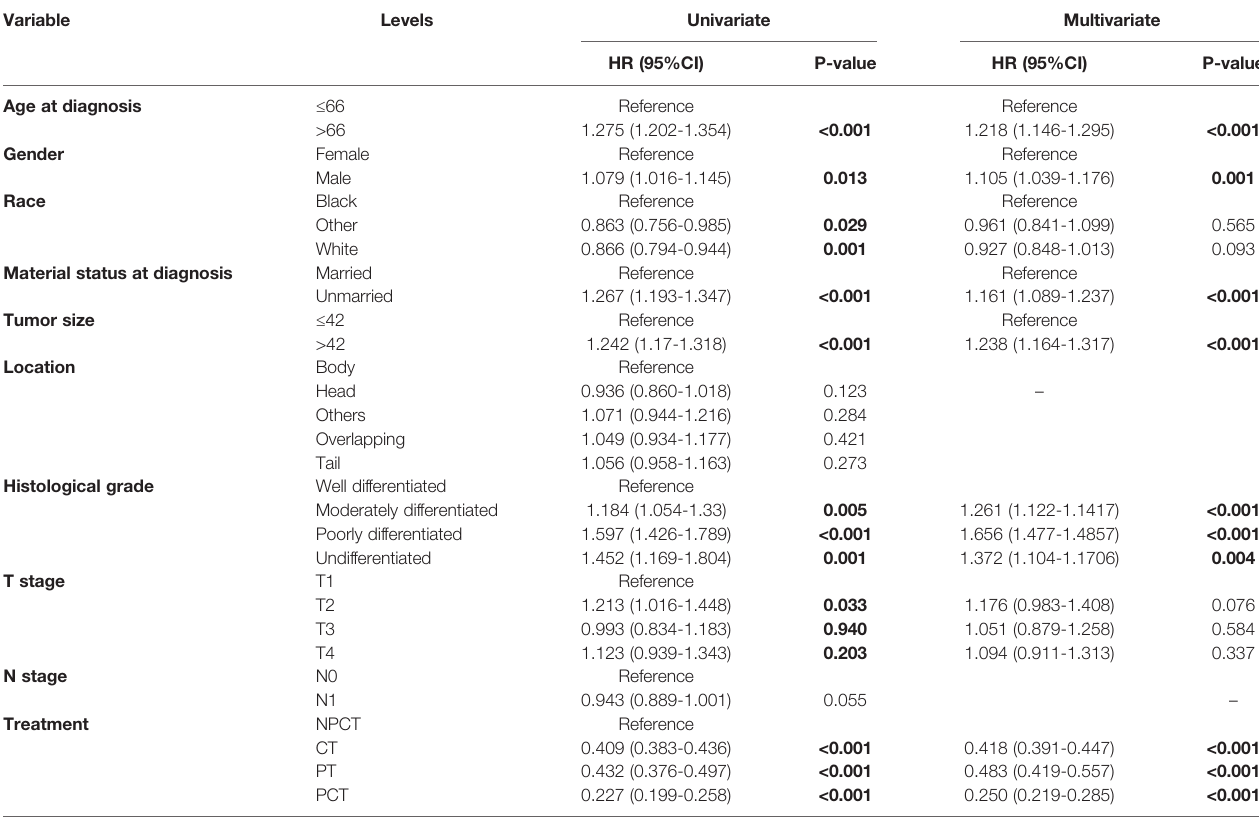
TABLE 2 | Univariate and multivariate analysis for mPC